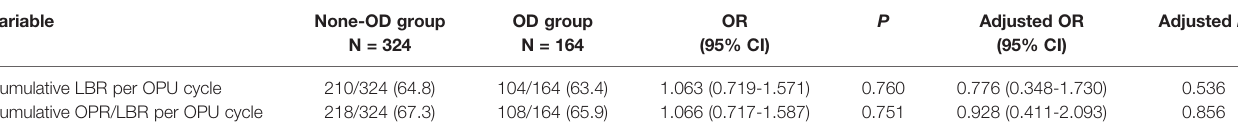
TABLE 4 | Cumulative live birth rate with or without oocyte degeneration in all transfer attempts.